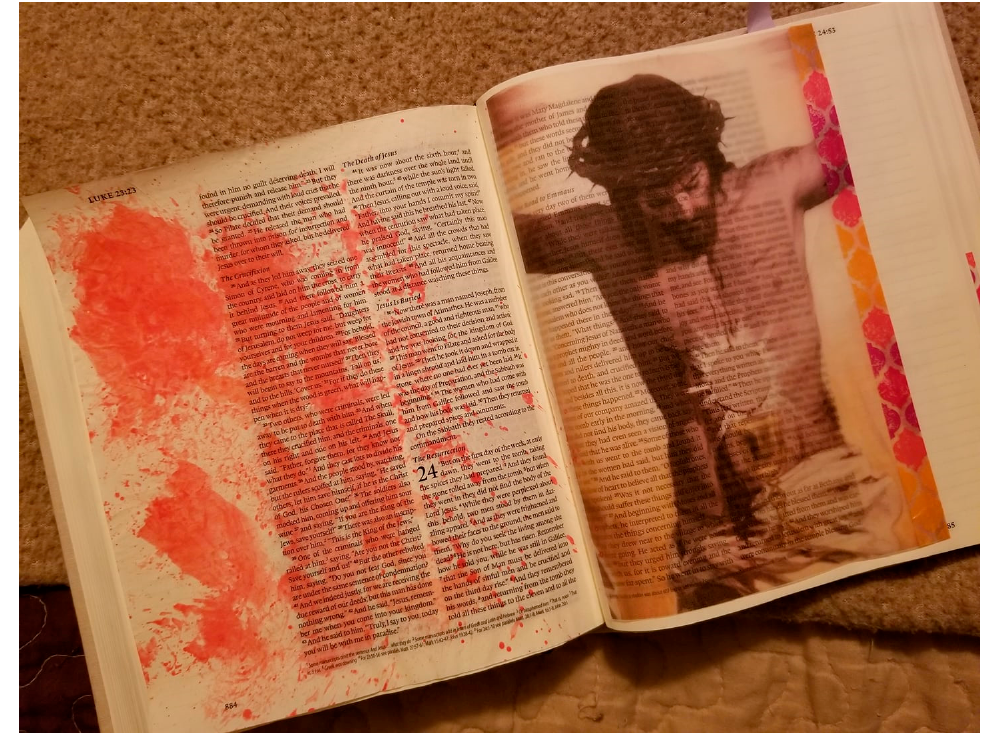
Figure 6. “The Crucifixion” (2018), Melissa Amyx (with kind permission of the journaler). Figure 6. “ The Crucifixion ” (2018), Melissa Amyx (with kind permission of the